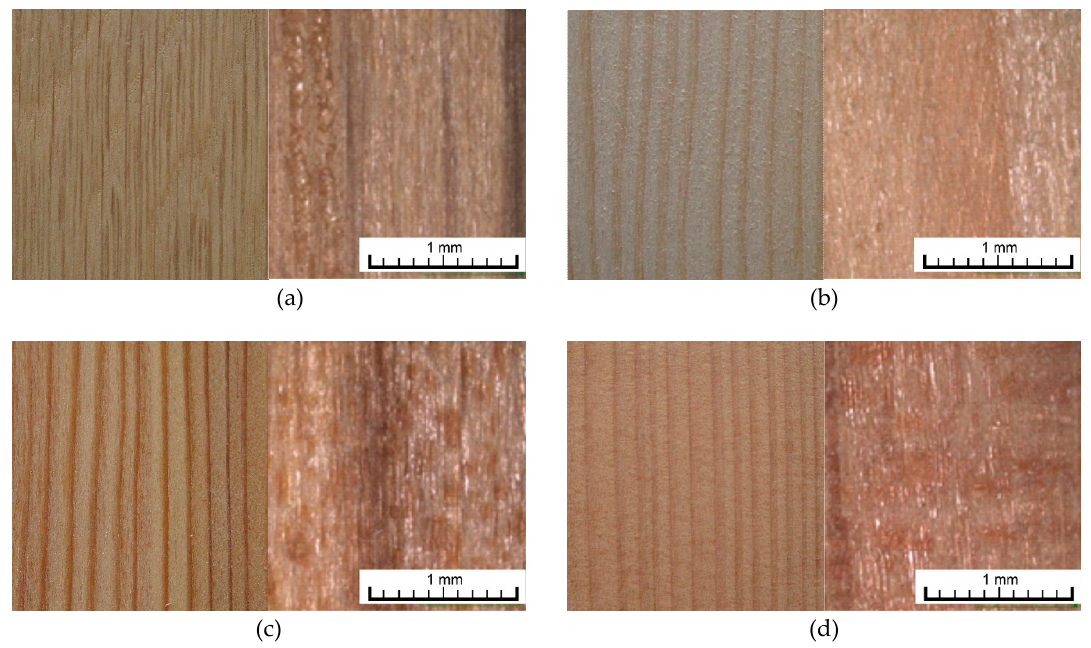
Figure 2. Photos of surfaces (left) and confocal laser scanning microscopy images (right) of wood species used in experiment (see also Table 1). ( a ) English oak; ( b ) Norway spruce; ( c ) European larch; ( d ) Douglas fir.